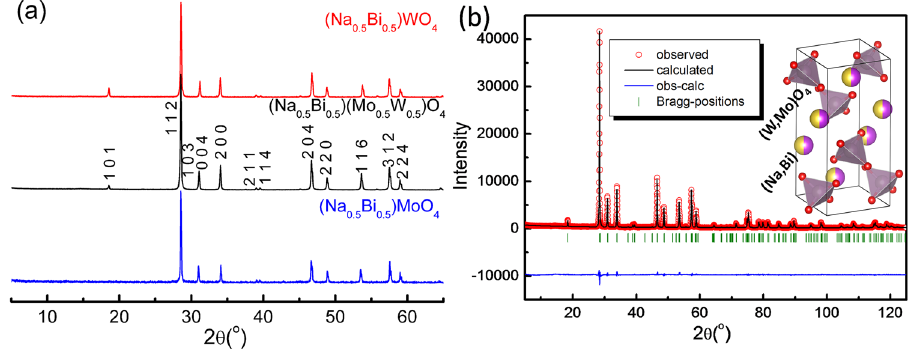
Figure 1. XRD patterns of the (Na 0.5 Bi 0.5 )(Mo 1 − x W x )O 4 (x = 0.0, x = 0.5 and x = 1.0) ceramics ( a ), the experimental (circles) and simulated (line) XRD patterns of the (Na 0.5 Bi 0.5 )(Mo 0.5 W 0.5 )O 4 composition sintered at 720 °C using space group I 4 1 /a (88) (R p = 9.08%, R wp = 9.95%, R exp = 6.25%) ( b ) (The short vertical lines represent Bragg reflection positions. The continuous line at the bottom shows the difference between experimental and simulated intensity).